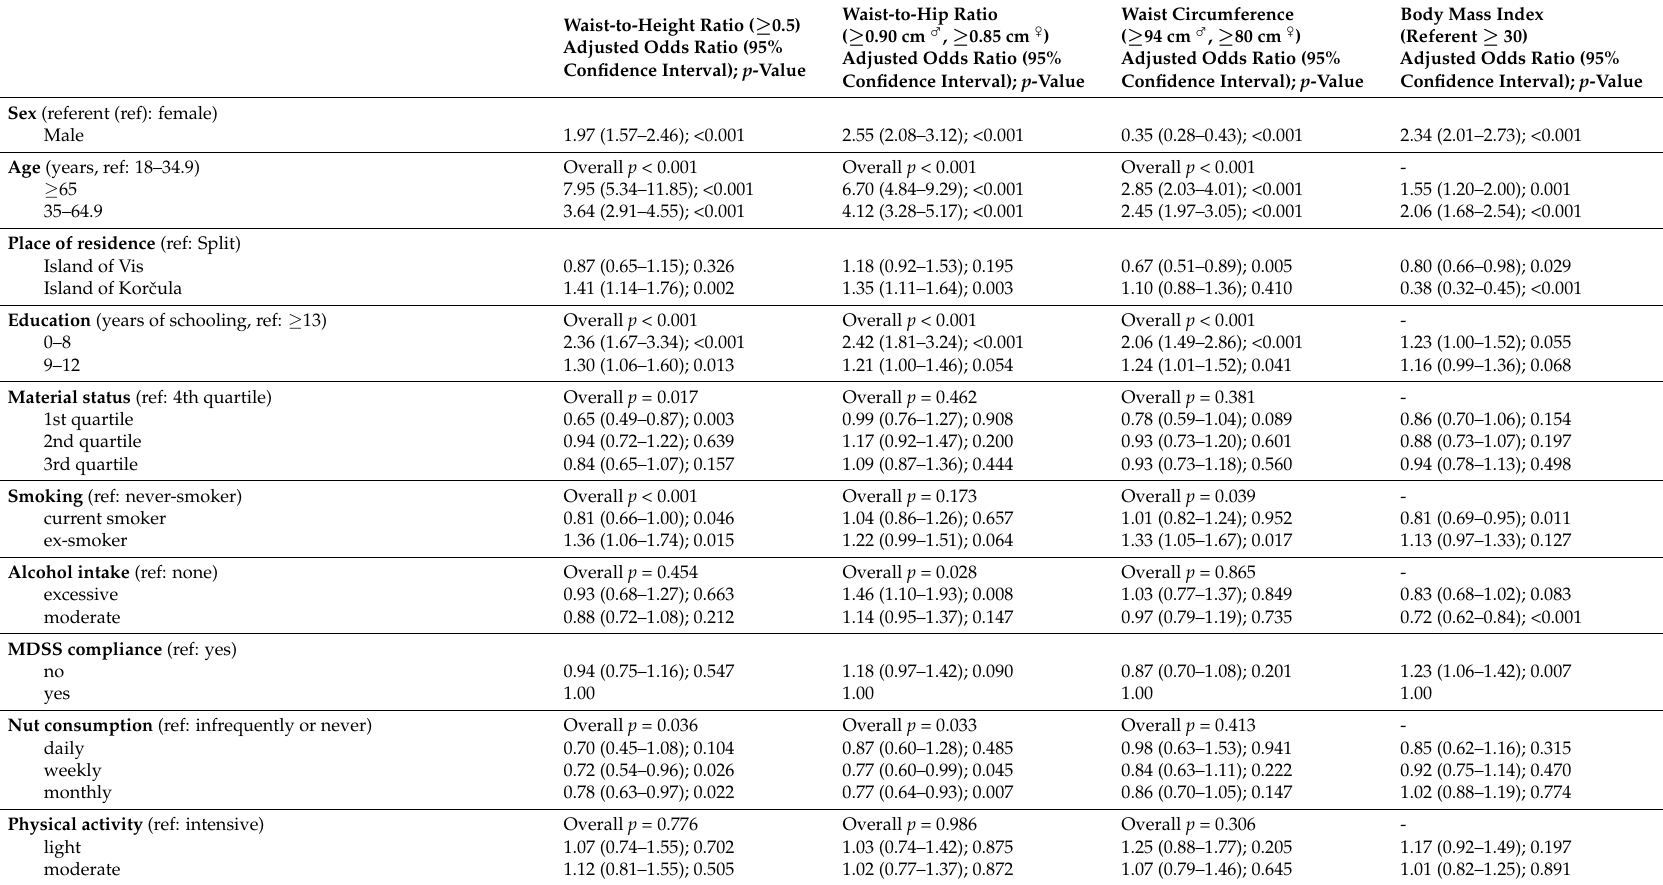
Table 3. Association of anthropometric indices with nut consumption frequency as determined by the regression models (sample size is 4011 subjects without previous cardiovascular disease diagnosis; all independent variables included in the model are listed in the